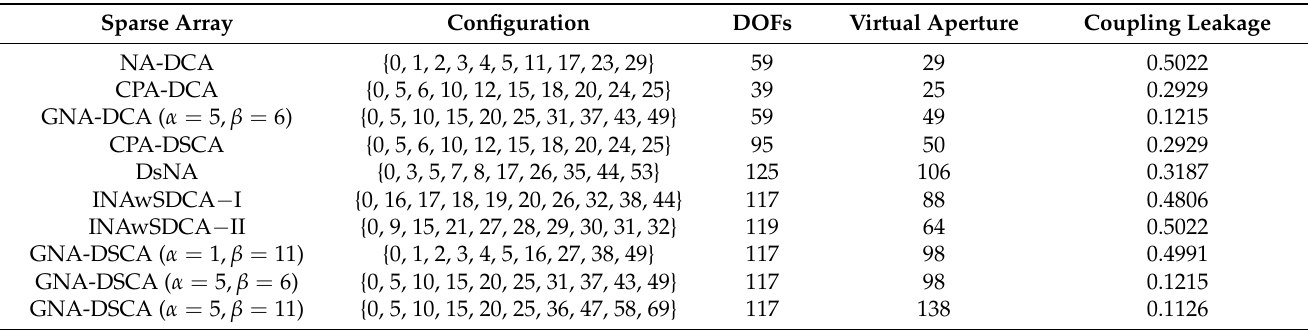
Table 3. Comparisons of configuration, DOFs, virtual aperture and coupling leakage; number of sensors G = 10. Sparse Array Configuration DOFs Virtual Aperture Coupling Leakage